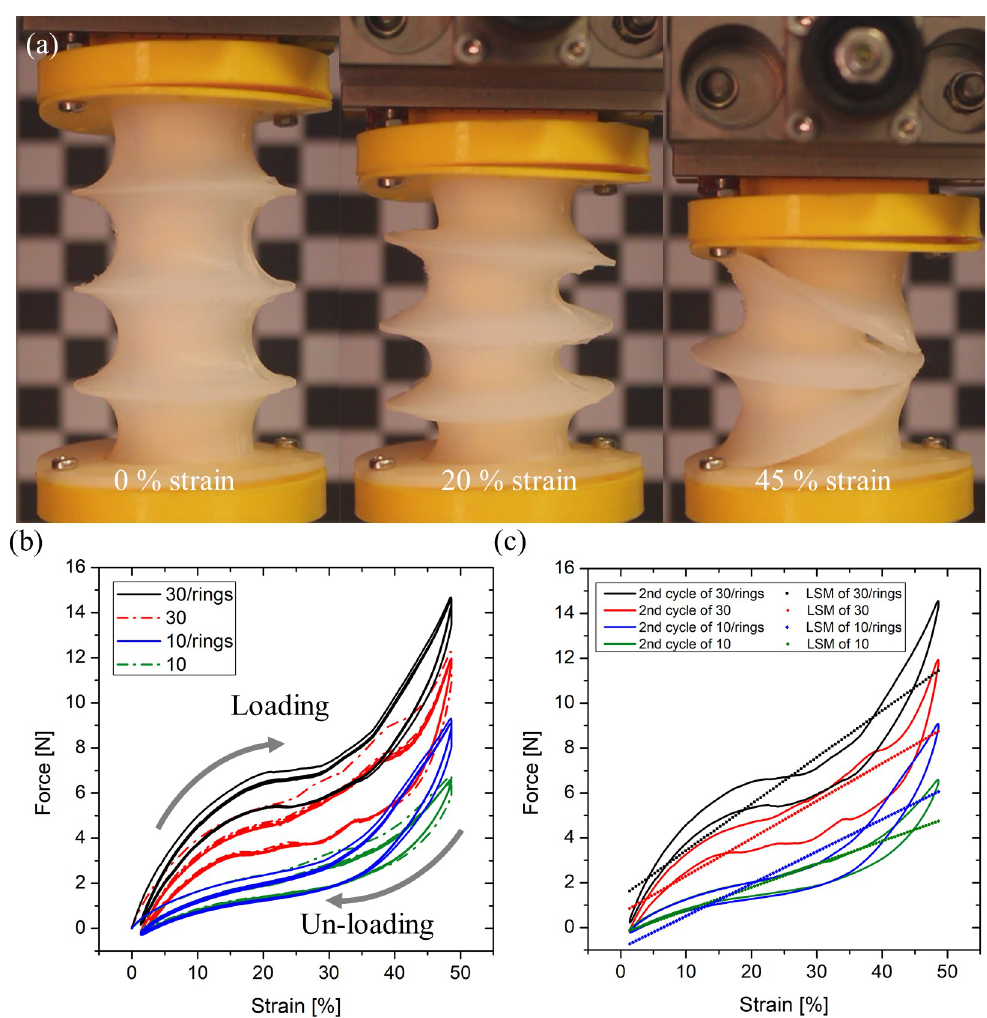
Fig 5. Cyclic compression test results: (a) images showing the compression testing at different strain phases; (b) the experimental results of loading/unloading cycles for each case; (c) linearly interpolated lines (LSM) for each